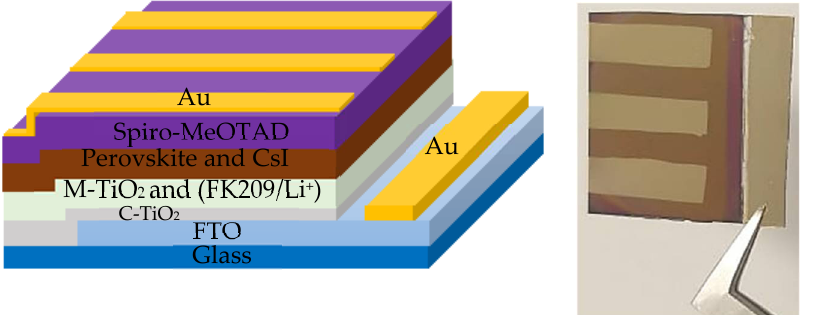
Figure 10. Left, schematic structure of the perovskite solar cell. Right, photograph of 2.5 × 2.5 cm 2 PSC fabricated in this study.